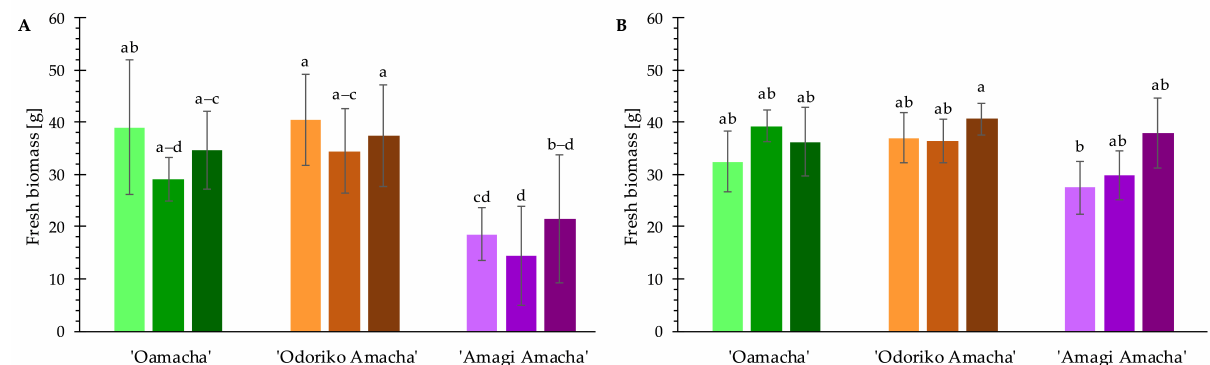
Figure 6. Total fresh biomass (g) of H. macrophylla subsp. serrata (green: ‘Oamacha’, orange: ‘Odoriko Amacha’, purple: ‘Amagi Amacha’) in two different years (( A ): 2018 and ( B ): 2019) at the end of two growing periods under three different light conditions (bright coloring: no shade, light coloring: partial shade, dark coloring: shade). Significant differences within a year calculated by ANOVA and Tukey HSD (n = 5, α = 0.05) are indicated by letters (a–d). Mean ± standard deviation values can be obtained via the Supplementary Materials Table